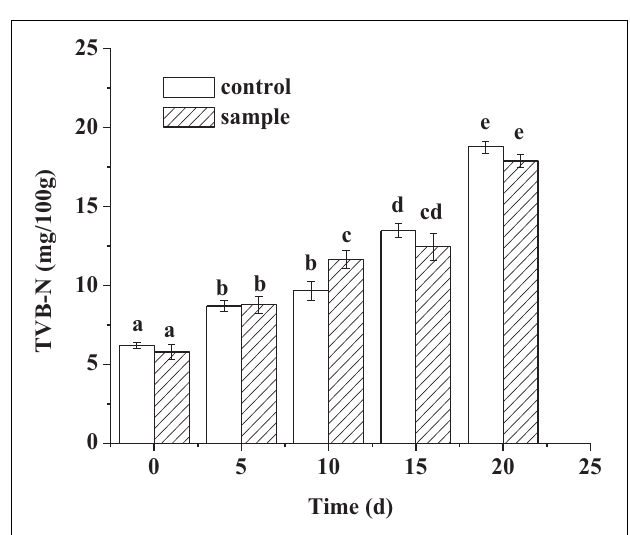
FIGURE 4 | The TVB-N content of the sausages during ripening period, in which different lowercase letters meant that TVB-N content was significantly different ( p <